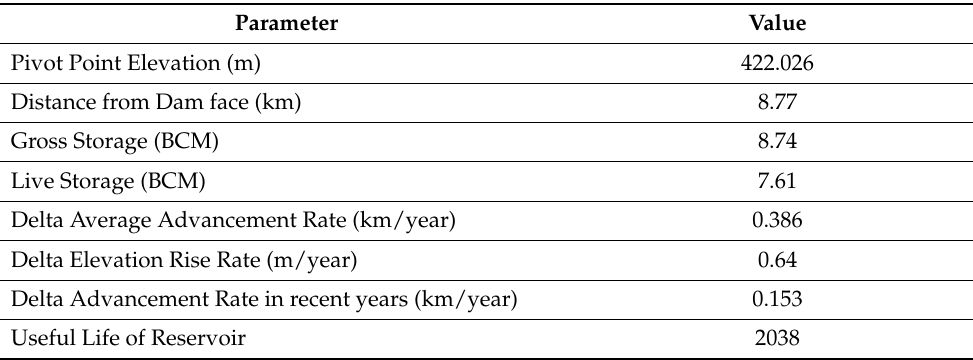
Table 3. Tarbela Reservoir and Sediment Delta Condition in 2017